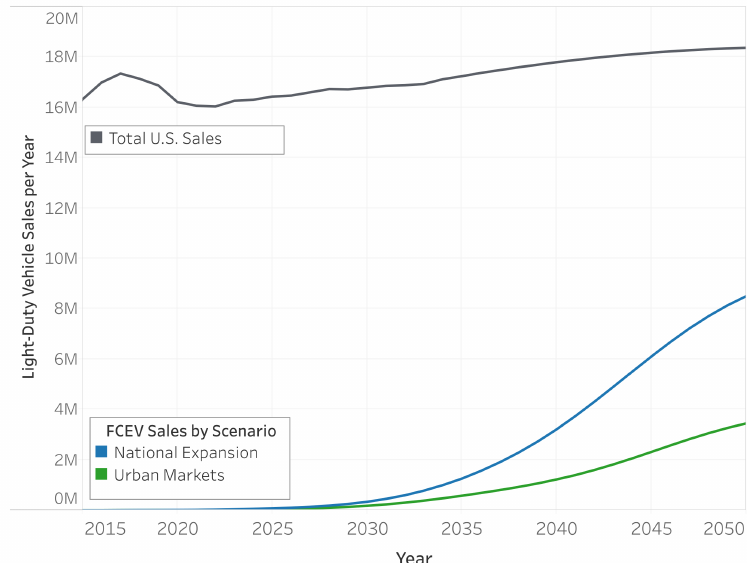
Figure 5. Fuel cell electric vehicles (FCEV) sales over time. The FCEV sales are SERA estimates whereas the total light-duty vehicle (LDV) sales are from the Annual Energy Outlook (AEO) 2017